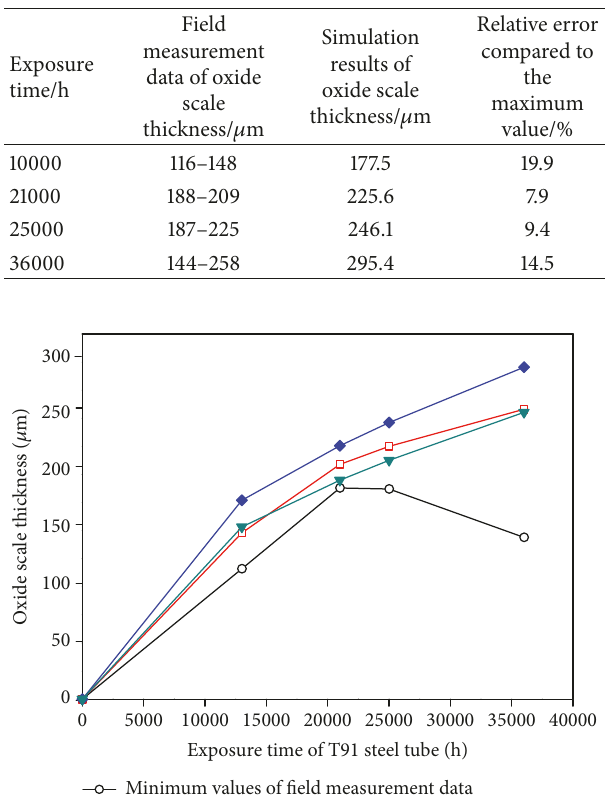
Table 5: Comparison between field measurement data and simula- tion results of oxide scale thickness.